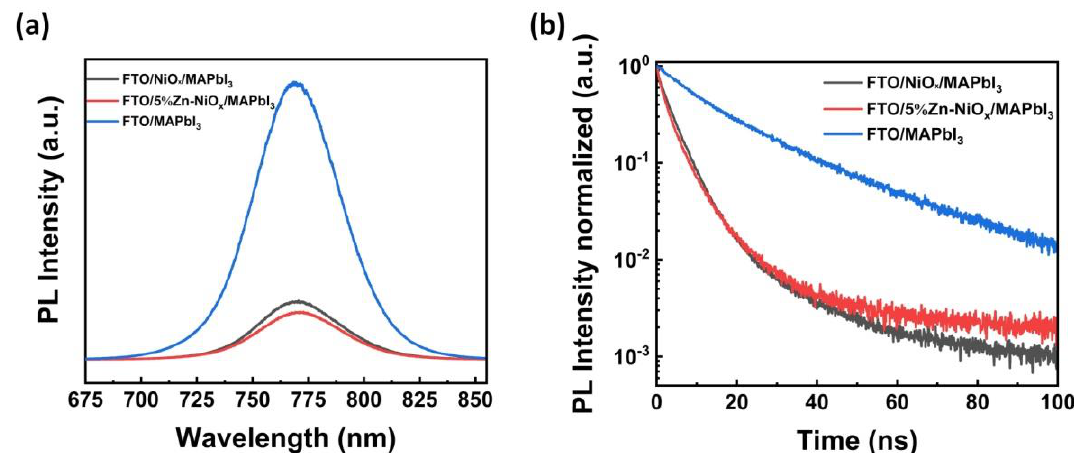
Table 2. PL lifetime parameters from the fitting curves of NiO x and 5% Zn-NiO x thin films.